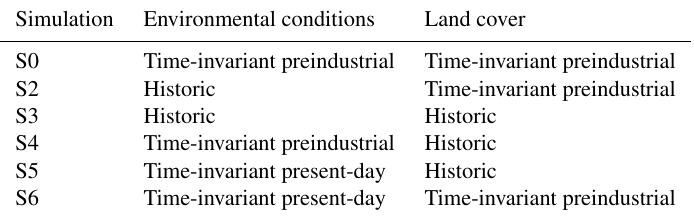
Table 3. DGVM simulations to calculate F LUC from the TRENDY v8 protocol (Friedlingstein et al.,